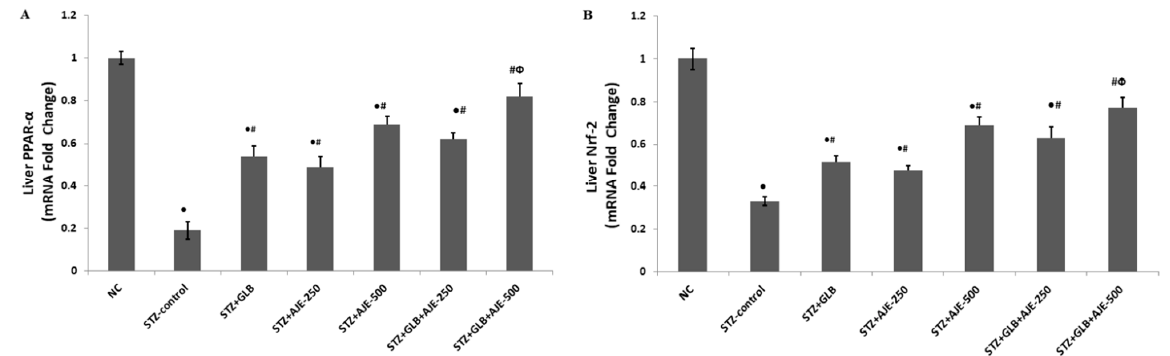
Figure 5. Effect of GLB, AJE, and their combination on hepatic mRNA expression of PPAR α ( A ) and Nrf-2 ( B ) in STZ-diabetic groups. Data presented as mean ± SEM ( n = 6) relative to the mRNA level in the NC and after being normalized to β -actin mRNA level. Multiple group comparisons were performed by analysis of variance (ANOVA) followed by Tukey’s multiple comparison post hoc test at p ≤ 0.05. • Statistically significant difference from the NC group at p ≤ 0.05. # Statistically significant difference from the STZ-control group at p ≤ 0.05. Փ Statistically significant difference from GLB group at p ≤ 0.05.